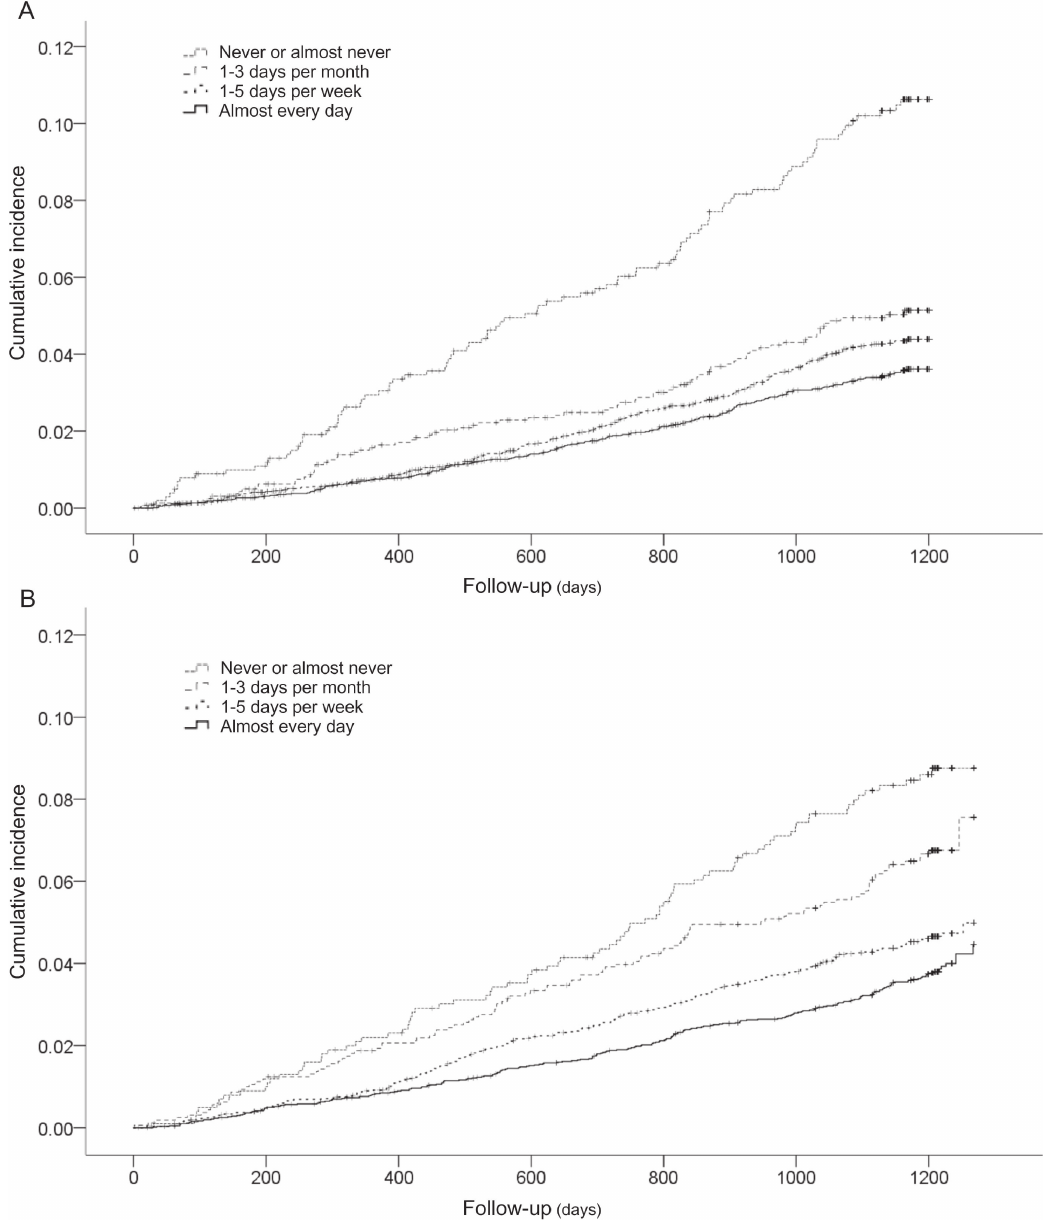
Figure 1. Kaplan-Meier curves showing cumulative incidence of functional disability (A) and all-cause mortality (B) according to the frequency of